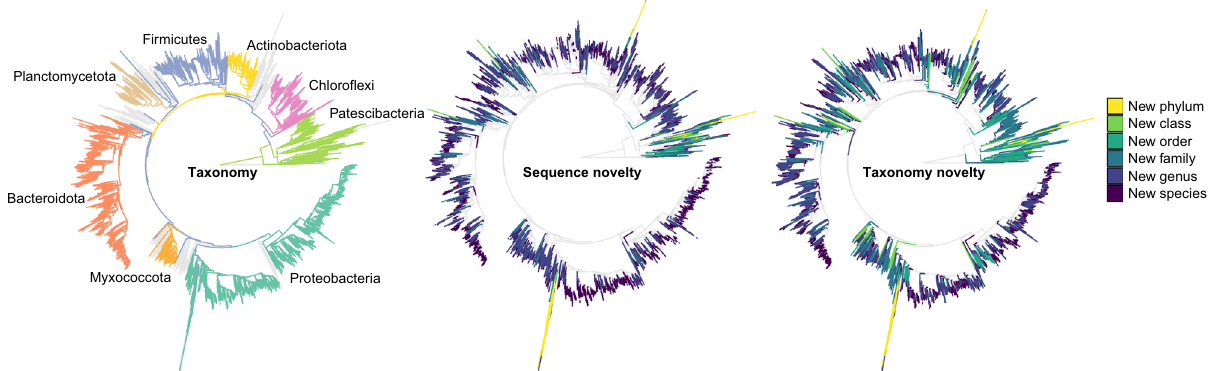
Fig. 2 Novel sequences and de novo taxa de fi ned in the MiDAS 4 reference database. The phylogenetic trees are based on a multiple alignment of all MiDAS 4 reference sequences, which were fi rst aligned against the global SILVA 138 alignment using the SINA aligner, and subsequently pruned according to the ssuref:bacteria positional variability by parsimony fi lter in ARB to remove hypervariable regions. The eight phyla with most FL-ASVs are highlighted in different colours. Sequence novelty was determined by the percent identity between each FL-ASV and their closest relative in the SILVA_138_SSURef_Nr99 database according to Usearch mapping and the taxonomic thresholds proposed by Yarza et al. 22 shown in Table 1. Taxonomy novelty was de fi ned based on the assignment of de novo taxa by AutoTax 20 AutoTax for 26 phyla (30.6% of observed), 83 classes (37.2% of Phylum-speci fi c phylogenetic trees were created to determine if observed), 297 orders (46.8% of observed), and more than 8000 the FL-ASV reference sequences that were assigned to de novo genera (86.3% of observed). Without the de novo taxonomy we phyla were actual phyla or simply artifacts related to the naive would not be able to discuss these taxa across studies to unveil sequence identity-based assignment of de novo placeholder their potential role in wastewater treatment systems. taxonomies (Supplementary Fig. 1a). The majority (65 FL-ASVs)